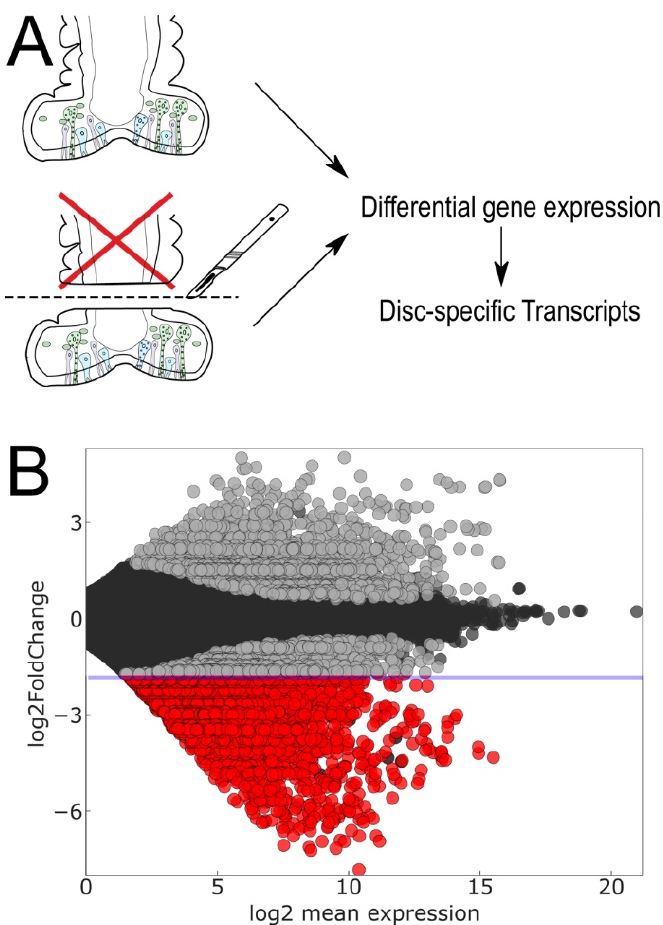
Figure 3. RNAseq and differential gene expression. Scheme ( A ) representing the differential gene expression approach. ( B ) Differentially expressed transcripts with an adjusted p -value < 0.01 are indicated in grey and red. 2129 disc-specific transcripts with a log2 fold change ≤ 2 are highlighted in red (see Table S1).